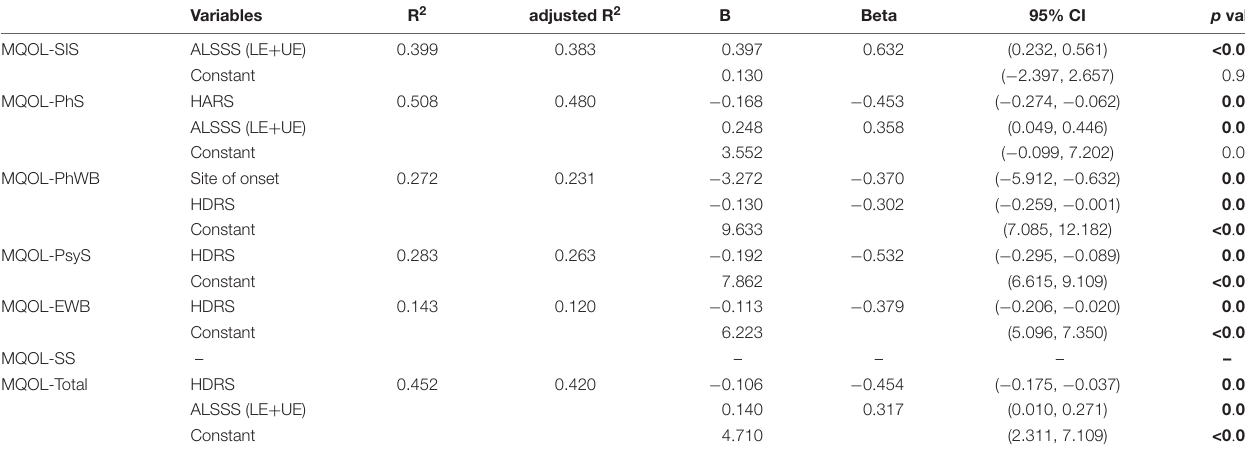
TABLE 5 | The impact of clinical variables on quality of life in the multiple linear regression.